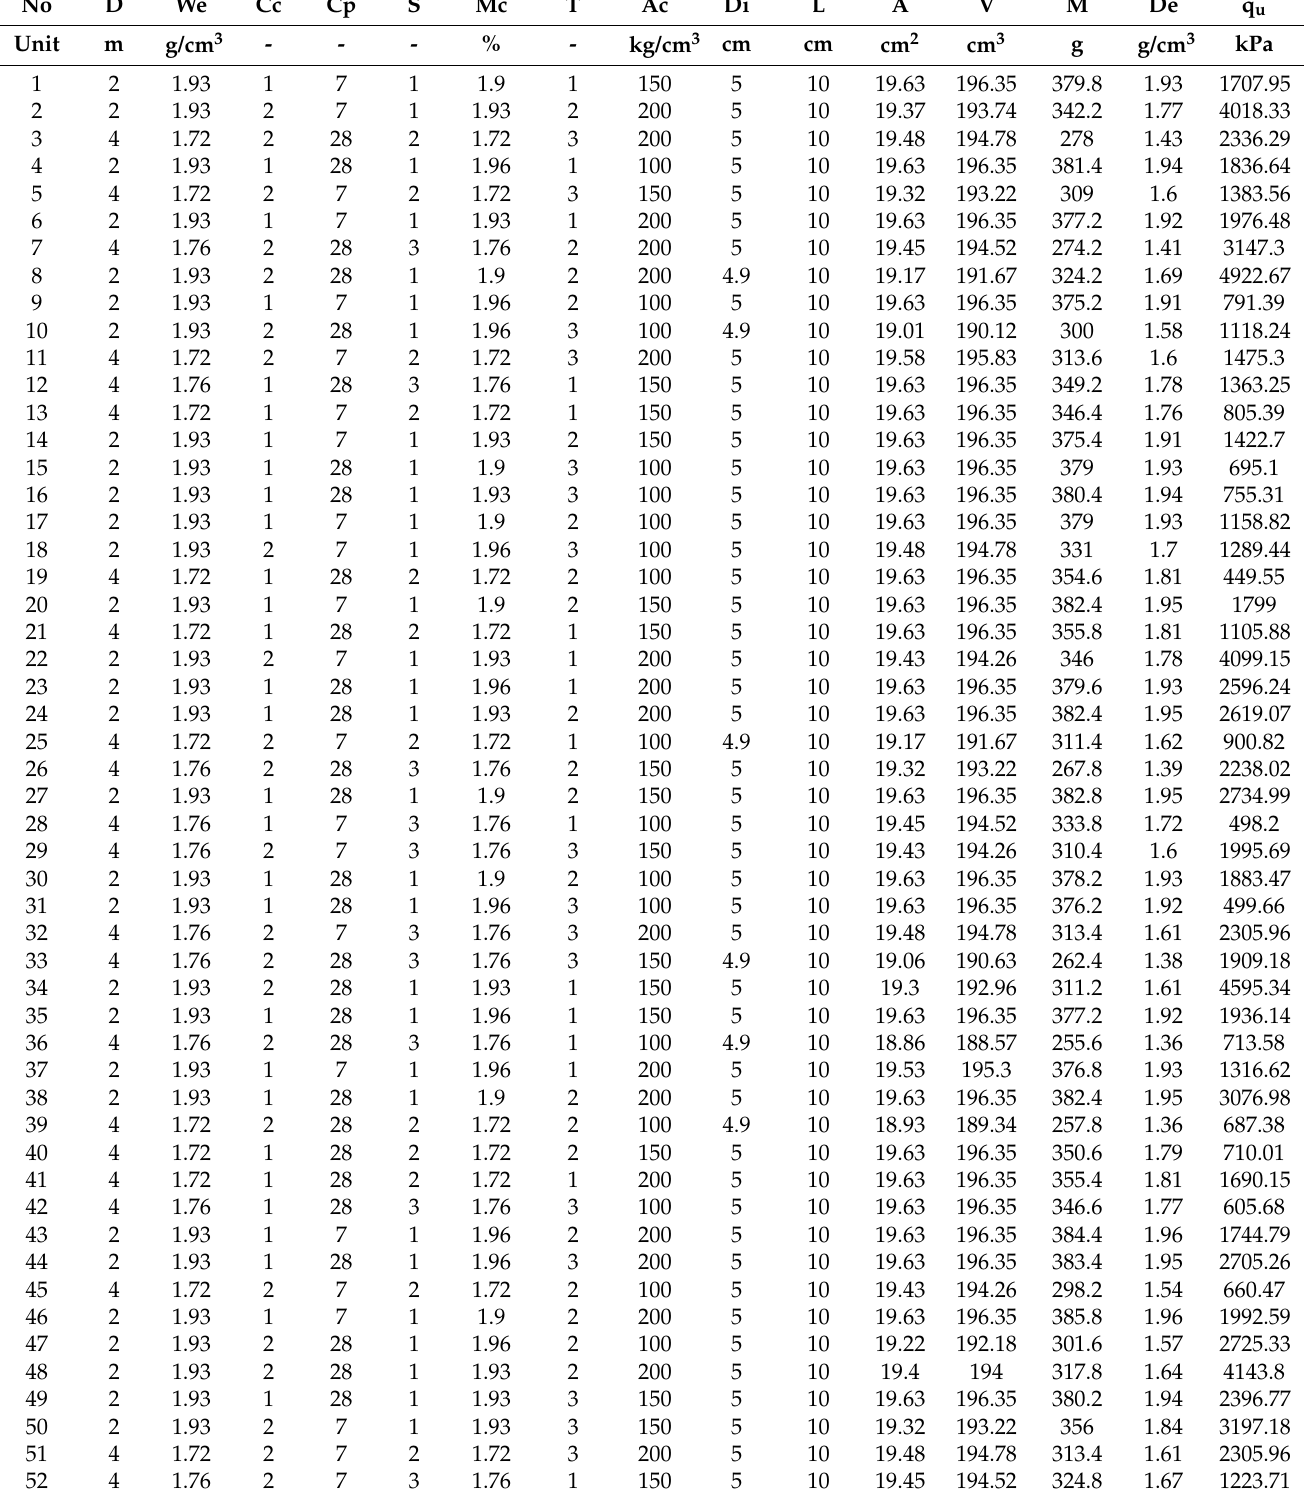
Table A1. An example of the data set of the present